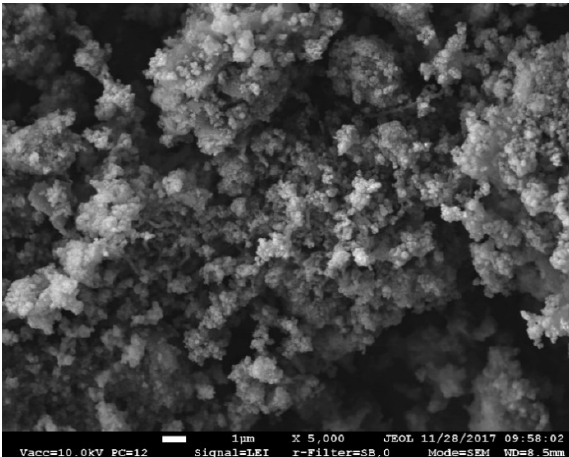
Figure 2. Scanning electron microscopy (SEM) image of tannery sludge (TS).